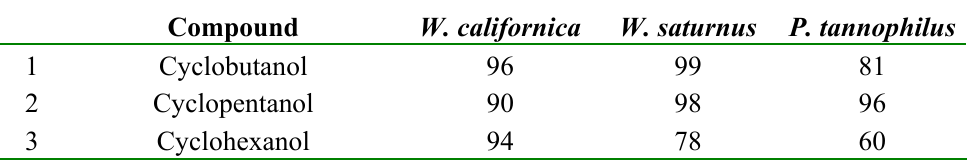
Table 4. Results obtained using the alcohol oxidation biocatalysts as batch fermenting